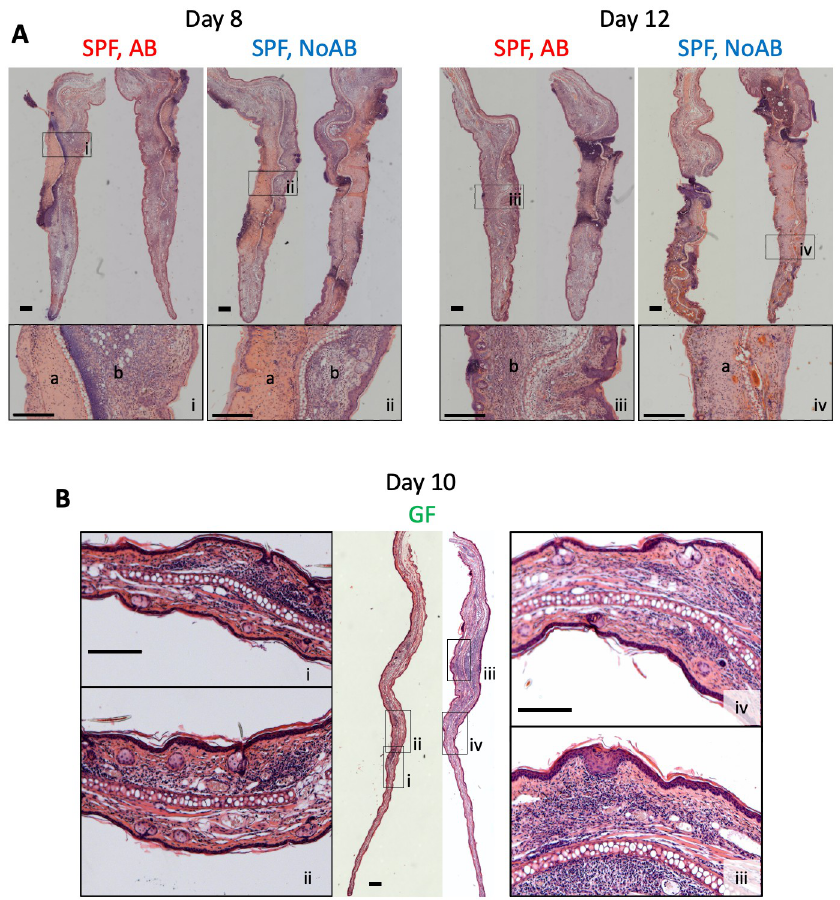
Fig 4. Histology of ear lesions after VACV infection. Specific pathogen free (SPF) or germ-free (GF) mice ( n = 5–15 per group) were injected i.d. with 10 4 PFU of VACV WR. Group SPF AB was injected daily i.p. with antibiotic ceftriaxone from d 1 to 11 p.i. Group SPF NoAB received i.p. injections with PBS. (A) Images of haematoxylin and eosin (H&E) stained transverse ear sections 8 and 12 d p.i. Bars = 300 μ m. Regions of necrotic tissue are labelled ‘a’ and regions of inflamed tissue labelled ‘b’. (B) Images of H&E stained transverse ear sections collected from GF mice 10 d p.i. Bars = 300 μ m.